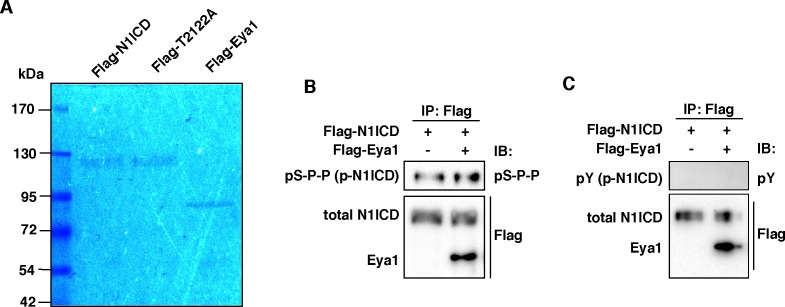
Eya1 does not affect serine or tyrosine phosphorylation level of Notch1 ICD.(A) Coomassie staining of SDS-PAGE showing purified Flag-Notch1 ICD, Flag-T2122A, Flag-Eya1 from 293T cells. (B–C) Analysis of phosphorylation status of Notch1 ICD. Transfected 293T cells in the presence (+) or absence (-) of Flag-Eya1 were immunoprecipitated with anti-FLAG M2 antibody. The phosphorylation status of Notch1 ICD was analysed by western blotting with antibodies targeting the phosphorylated S/T/Y residues anti-phospho-Serine-Proline-Proline antibody (pS-P-P), anti-phospho-Tyrosine antibody (pY) or anti-Flag antibody (n = 3).